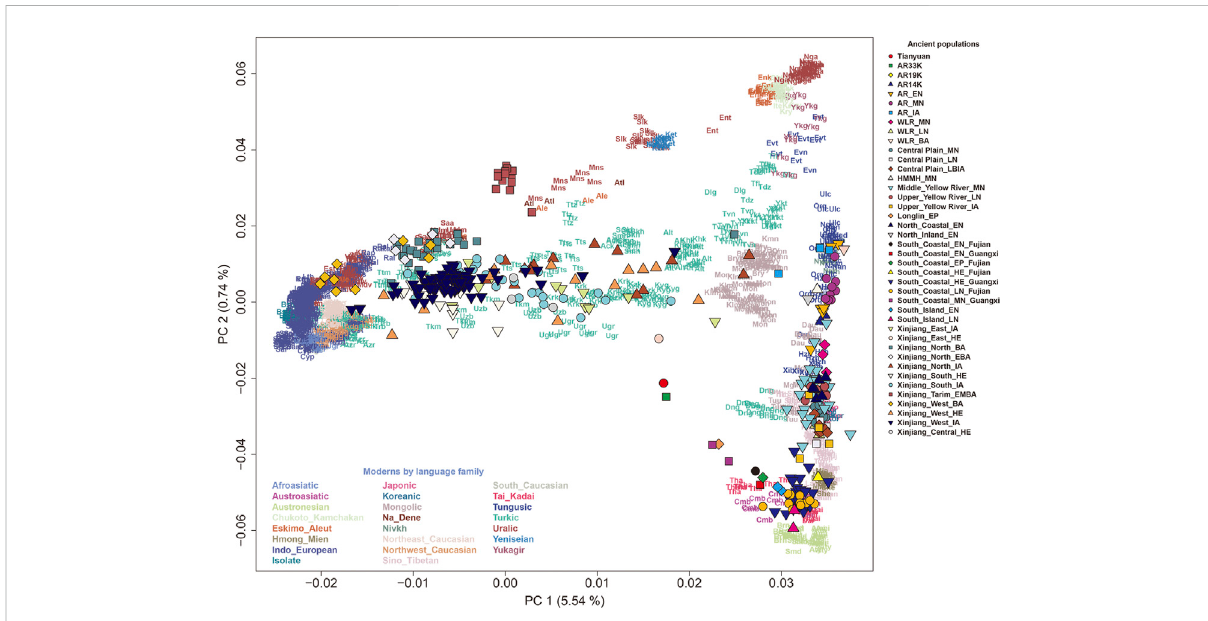
FIGURE 1 PCA Analysis for ancient Chinese populations. The PCA was constructed from present-day Eurasians in the Human Origins dataset, and the ancient individuals were projected onto the top